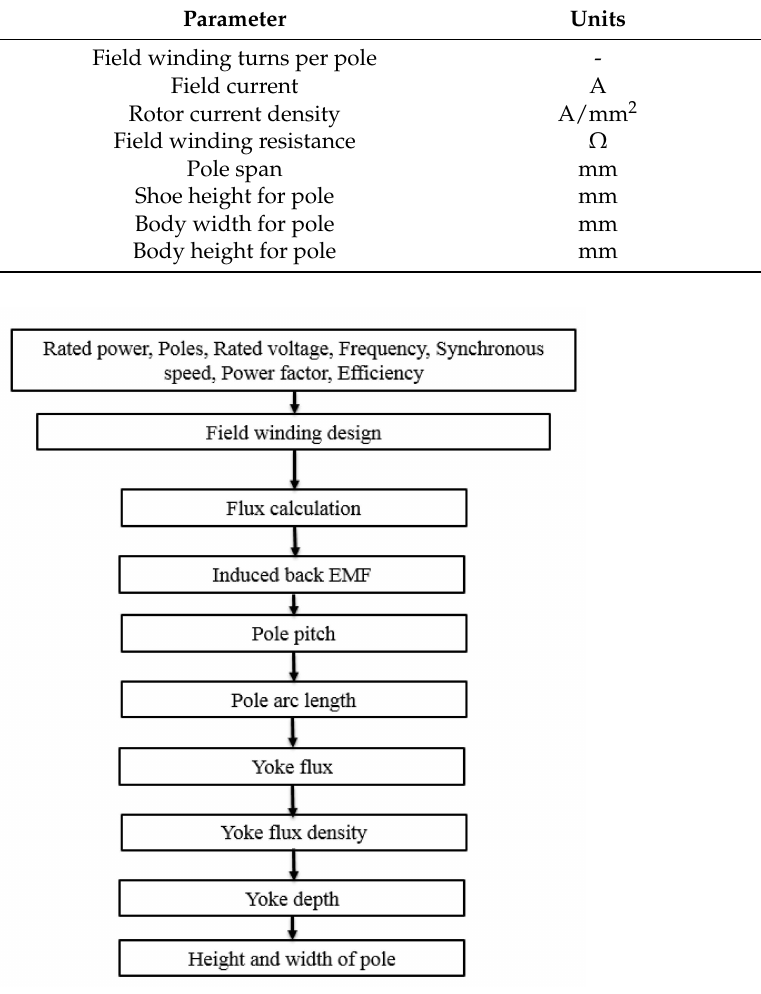
Figure 2. Salient pole wound rotor design